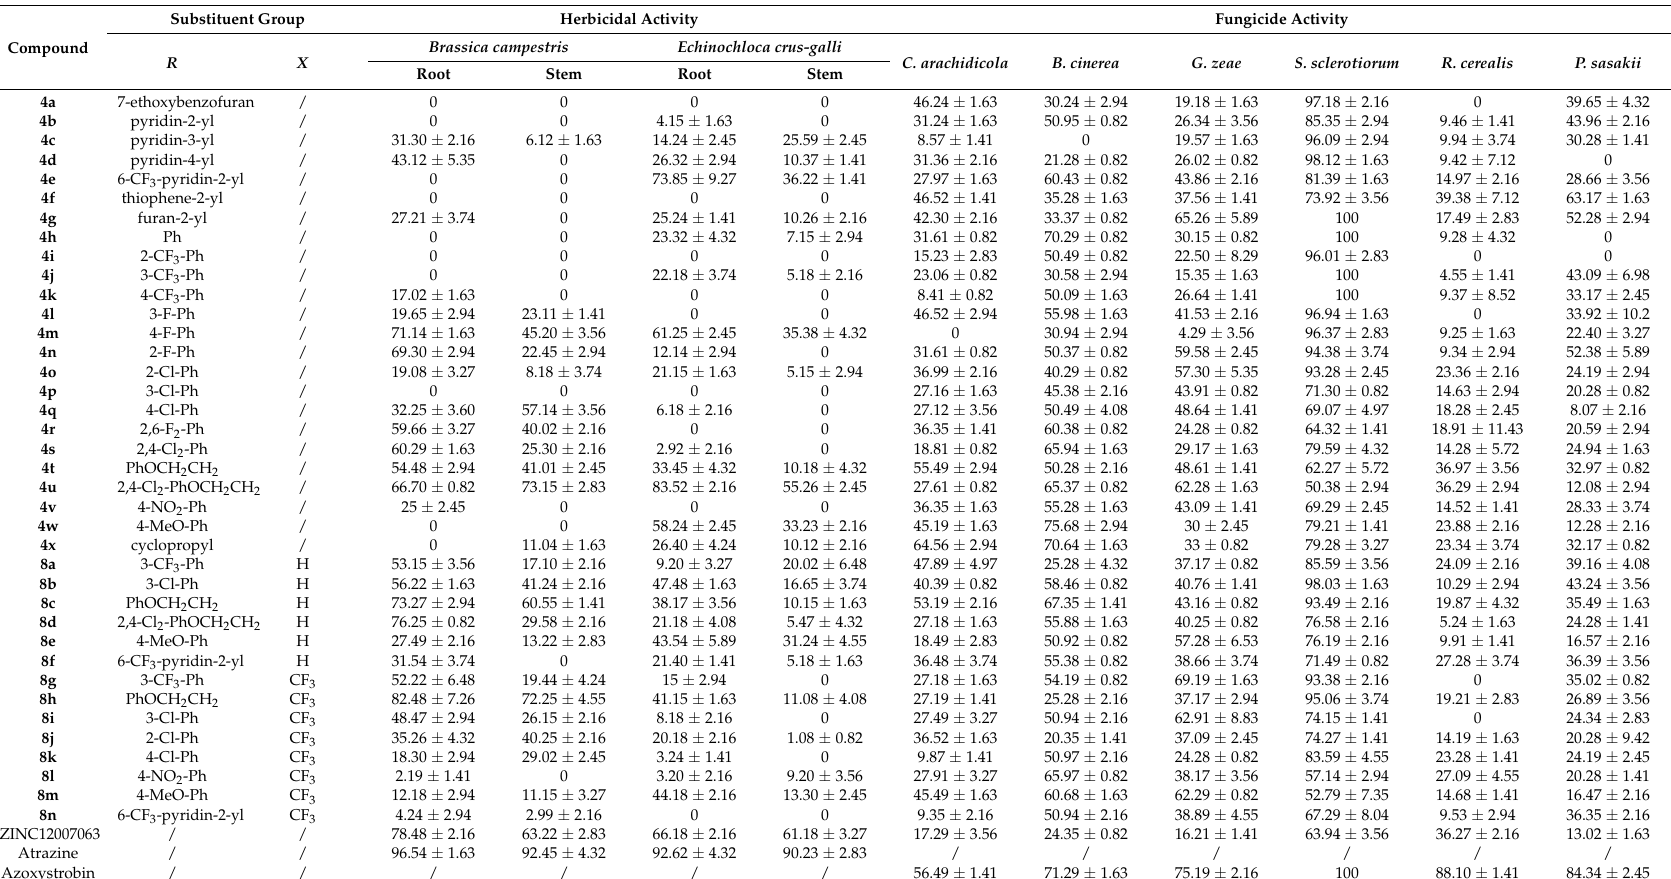
Table 2. Bioactivity of compounds ( 4a – 4x and 8a – 8n ) through growth inhibition method (inhibition rate %, herbicide activity at 500 mg/L and fungicide activity at 50